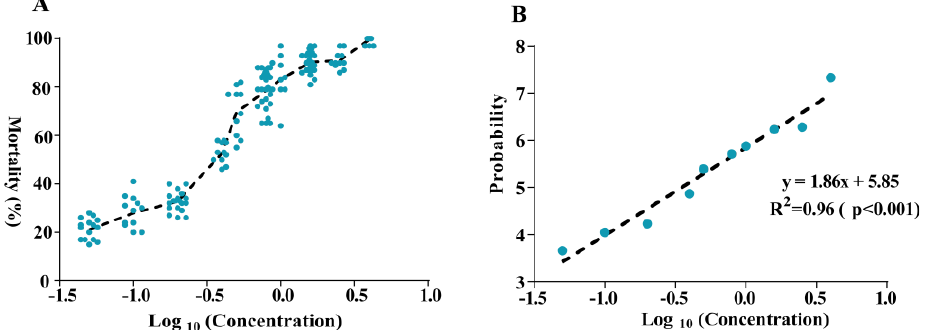
Figure 2. The dose-mortality curve and toxicity regression of broflanilide against cotton aphids. ( A ): The dose-mortality curve of broflanilide to Aphis gossypii . The concentration logarithm as X-axis and mortality as Y-axis. ( B ): The toxicity regression curve of broflanilide to Aphis gossypii . The concentration logarithm as X-axis and mortality probability value as Y-axis. The correlation coefficient is 0.96 ( p < 0.001).